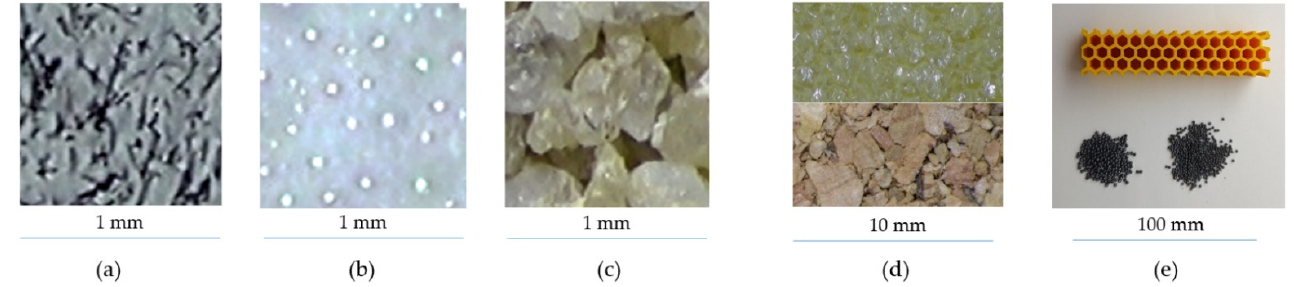
Figure 5. ( a ) Carbon dust, ( b ) glass hollow microspheres, ( c ) silica sand, ( d ) polymer foam (upper), cork (lower), ( e ) plastic honeycomb (upper) and lead particles (lower).